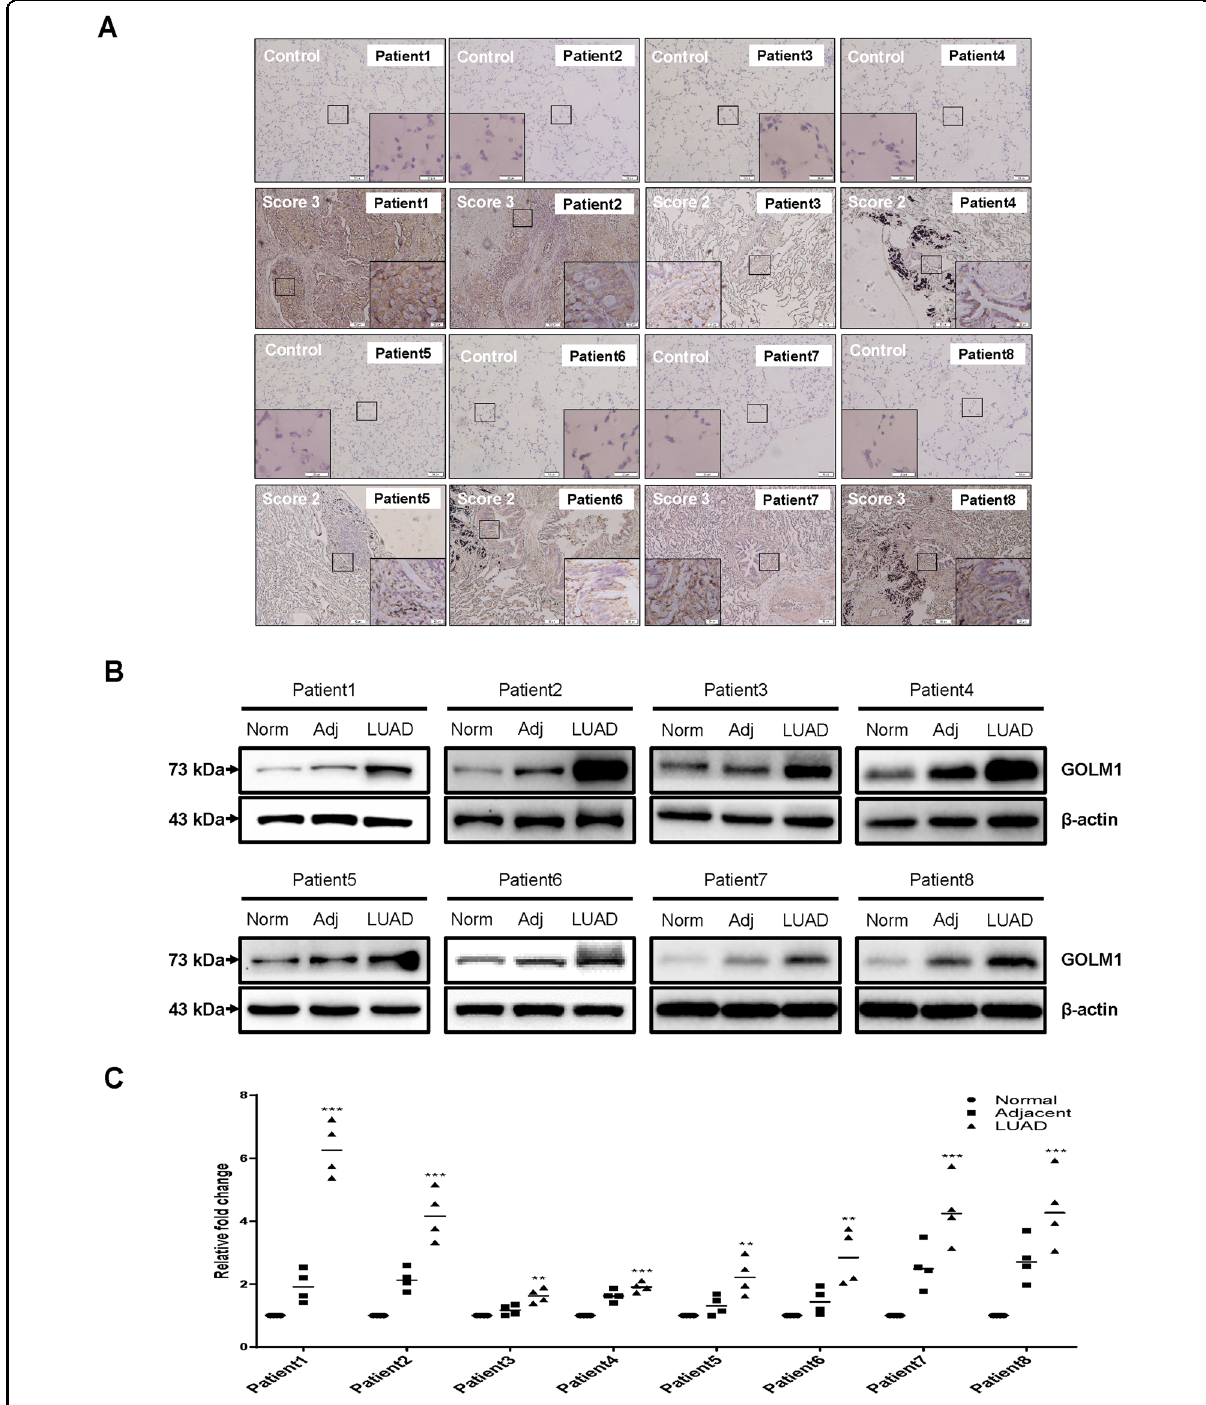
Fig. 2 GOLM1 expression is upregulated in lung cancer tissues. A GOLM1 expression in clinical samples was measured through immunohistochemical staining. Results were graded by a standardized immunoreactivity score system widely used in clinic. GOLM1 expression of representative images were scored more than two in all clinical samples. B , C Western blot analysis of GOLM1 protein in clinical samples of eight patients. Num normal tissue, Adj adjacent tissue, LUAD lung adenocarcinoma tissue. Data were means ± SEM. * P < 0.05, ** P < 0.01, *** P < 0.001, n =